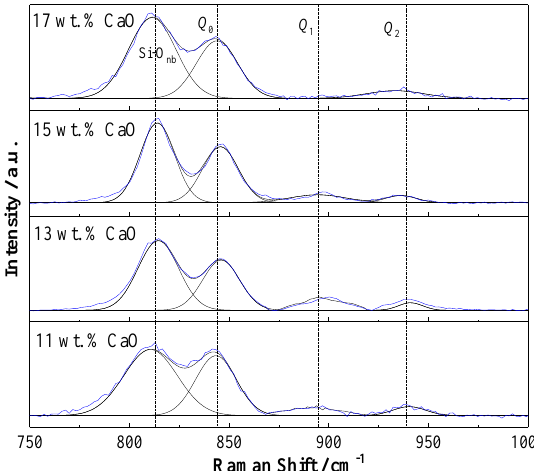
Figure 6. Raman spectra of nickel slag with di ff erent CaO content quenched at 1150 ◦ C.